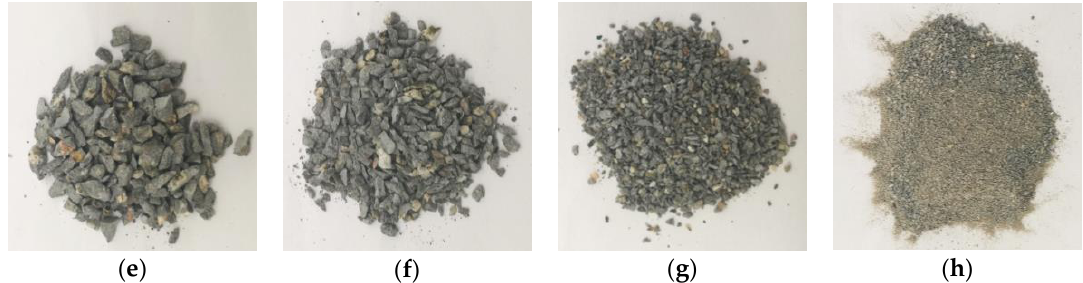
Figure 8. Particle size distribution of crushing blocks under the condition of 0 freeze-thaw cycle with loading speed of 5.4 m/s. ( a ) Greater than 19 mm; ( b ) 16~19 mm; ( c ) 9.6~16 mm; ( d ) 4.75~9.6 mm; ( e )